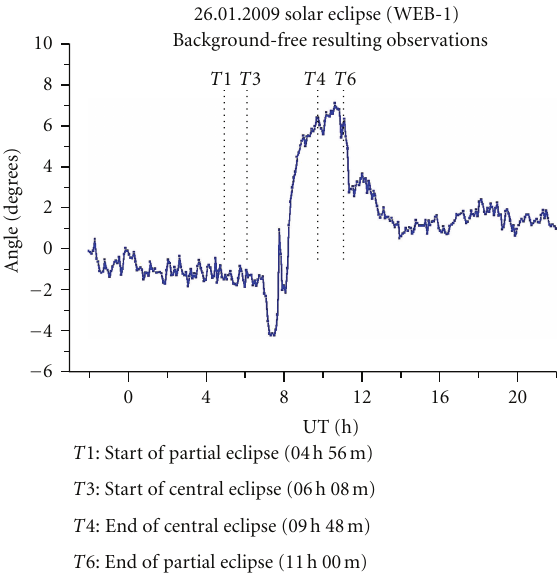
Figure 3: Record of the solar eclipse freed from the influence of normal daily variations.